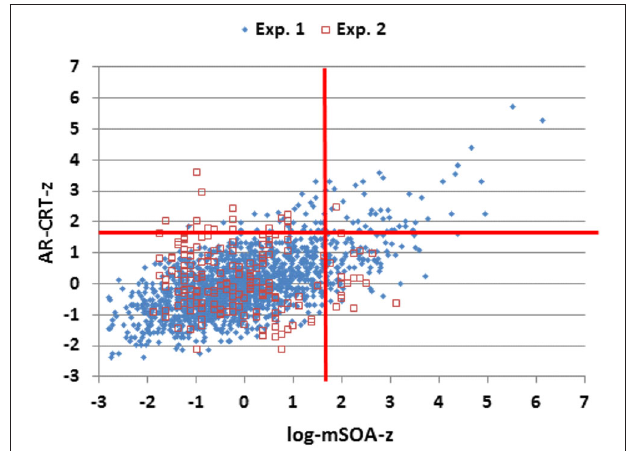
FIGURE 7 | Z -scores of age-regressed (AR) CRTs and log-mSOAs . Z -scores were calculated based on means and age-regression slopes from Experiment 1 data for individual subjects in Experiments 1 and 2. The abnormal performance thresholds (red lines, p < 0.05) were derived from Experiment 1